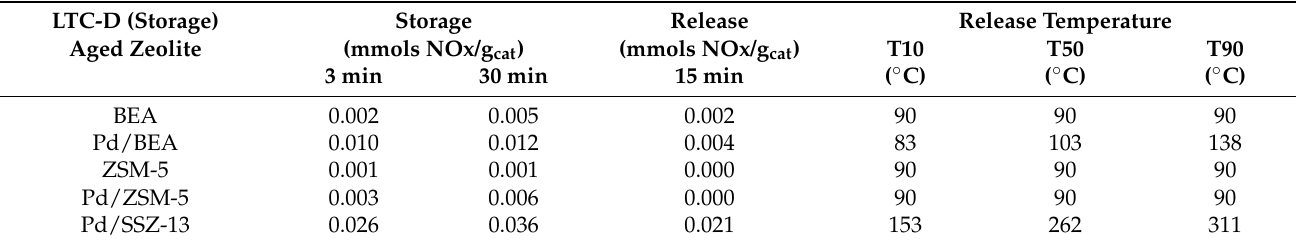
Table 4. NOx storage values (mmol/g cat ) for hydrothermally aged samples. The total amount of observed NOx released during the first 15 min of the ramp, and the temperature where 10% (T10), 50% (T50), or 90% (T90) of NOx is released is also